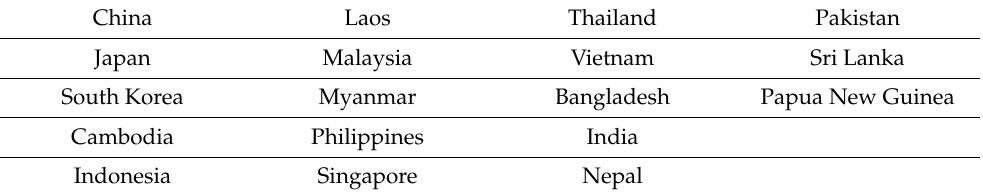
Table A4. East Asia, South-East Asia, South Asia and The Pacific (excluding Australia and New Zealand)—18 Countries.